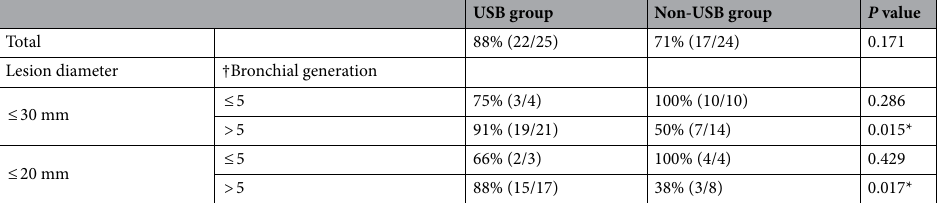
Table 2. Diagnostic yield. Values shown are percentages (diagnosed numbers/total number). USB, ultraselective biopsy. * P -value < 0.05. † Bronchial generation nearest to or leading to the target, counted by direct oblique method (DOM).